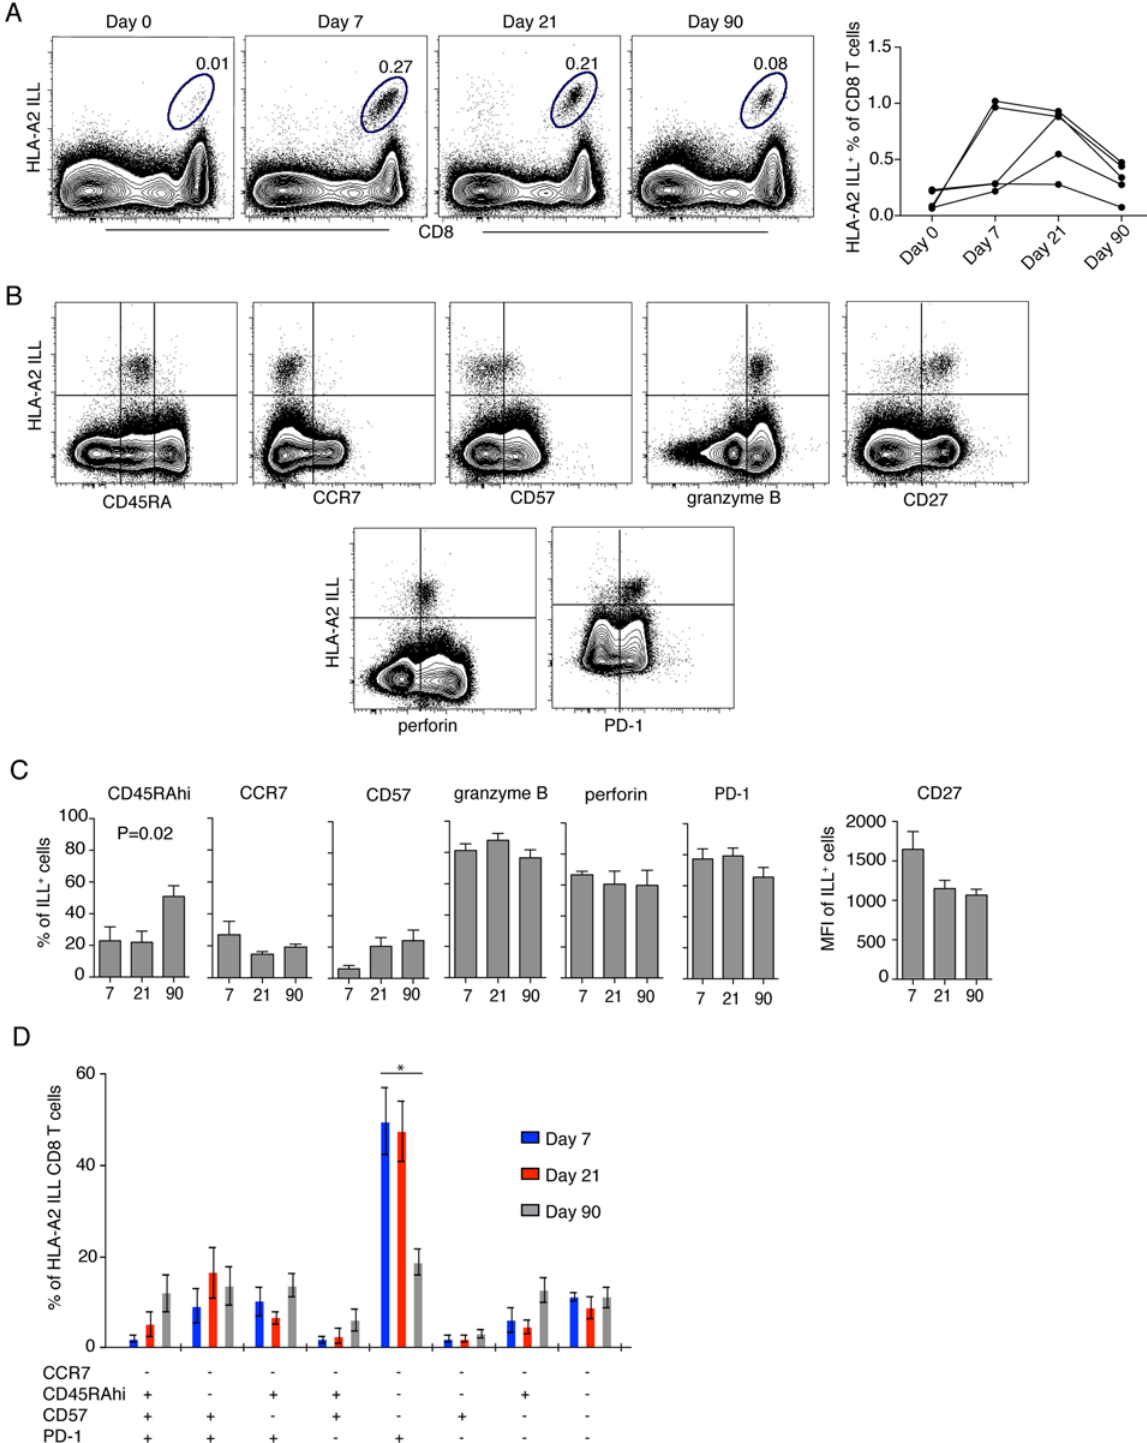
Figure 4. Effector and memory differentiation of TBEV-specific CD8 T cells. (A) Flow plots show HLA-A2 NS3 ILL + CD8 T cells in one representative infected donor at day 0, 7, 21 and 90 after hospitalization (left panel), NS3 ILL-specific cells over time in five donors (right panel). (B) Flow plots representing the phenotype of TBEV-specific CD8 T cells. Plots are gated on total CD8 T cells at day 7 after hospitalization from one infected patient. (C) Results from the longitudinal phenotypic analysis of HLA-A2 NS3 ILL + CD8 T cells present in the blood of five HLA-A2 patients. Bar plots show the median and 10 – 90th percentiles at day 7, 21 or 90 after hospitalization of CD45RA, CCR7, CD57, granzyme B, perforin and PD-1. CD27 is presented as mean fluorescence